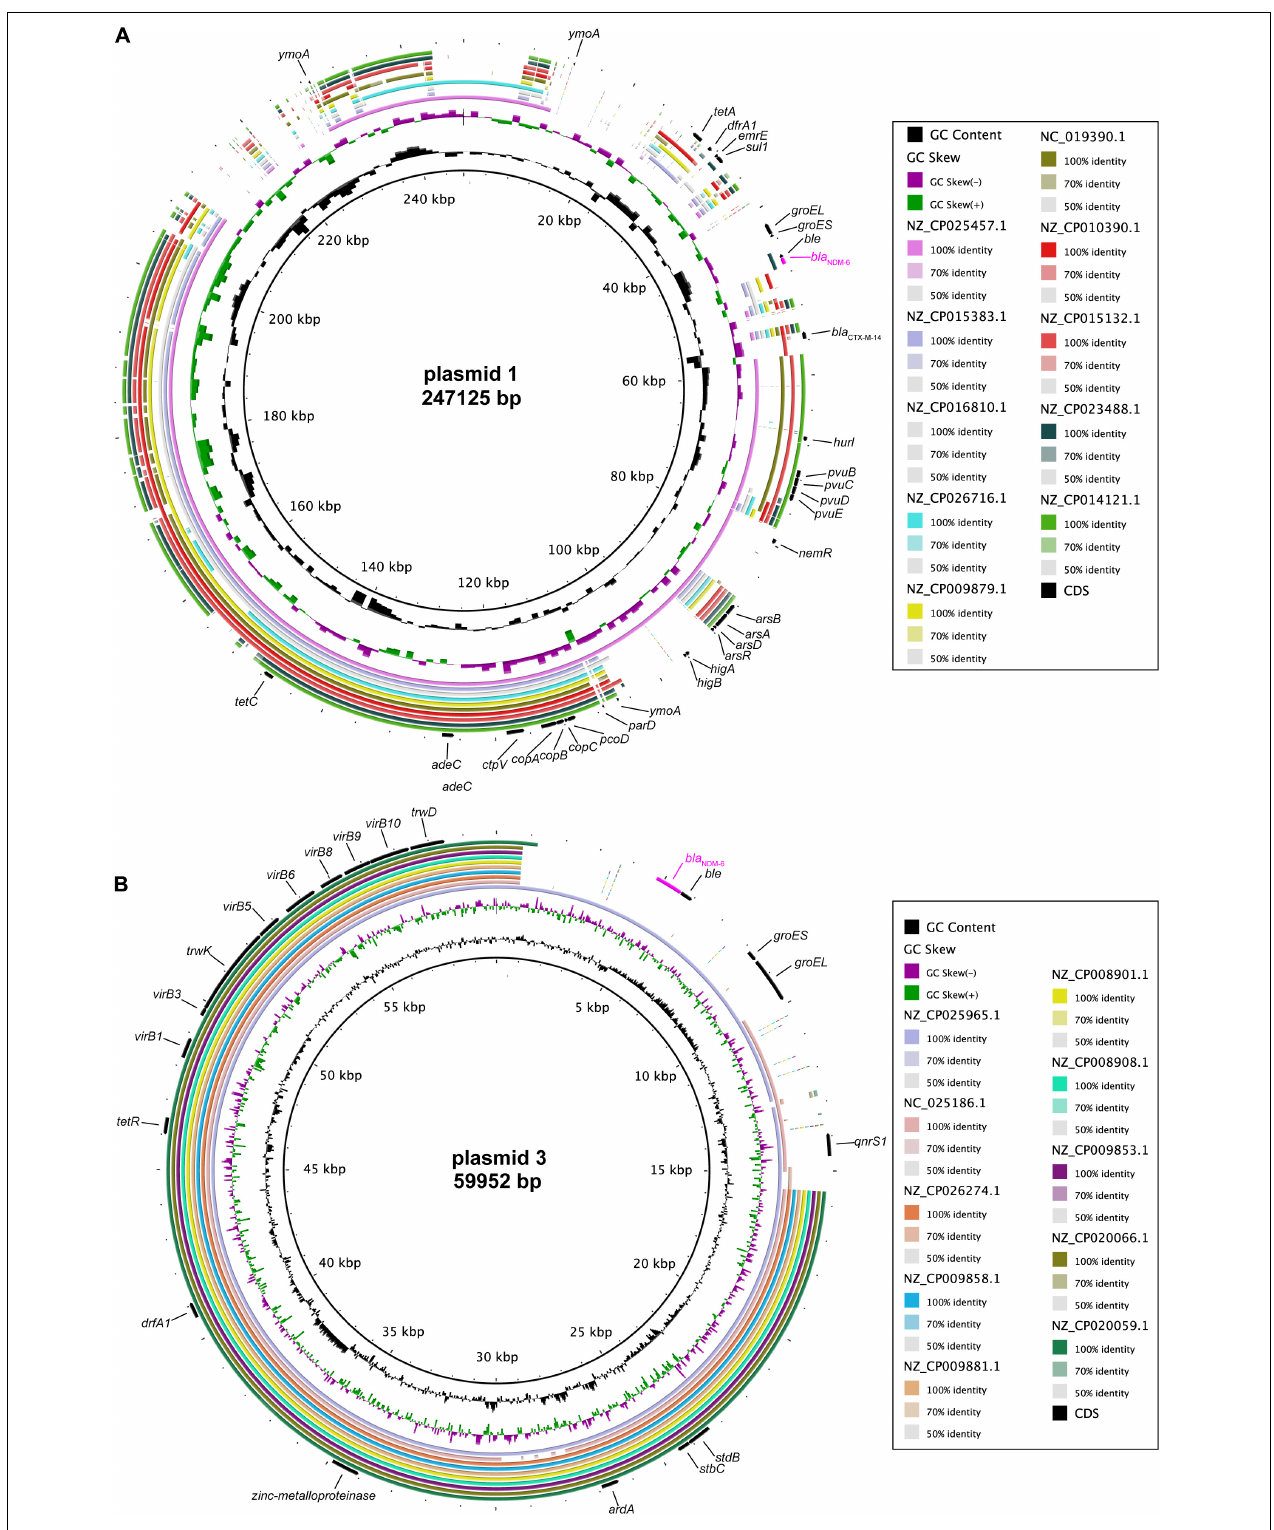
FIGURE 2 | Comparative genomics of bla NDM − 6 -harbouring plasmids. Comparison of plasmid 1 (A) and plasmid 3 (B) with closely related plasmids deposited in GenBank. Concentric rings represent the similarity between the reference sequence in the inner ring and other sequences in the outer rings. Colour levels indicate the result of BLASTn with a matched degree in the shared